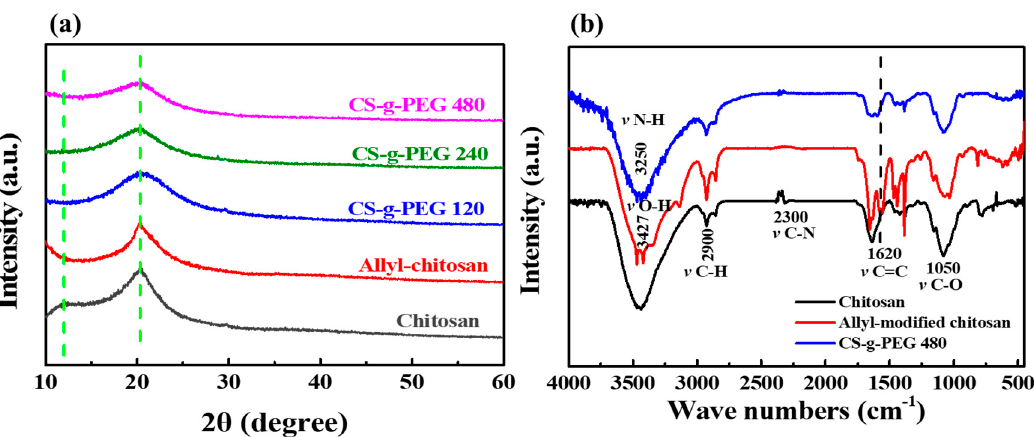
Figure 1. ( a ) X-ray diffraction (XRD) patterns of chitosan, allyl-chitosan and CS-g-PEG 120, 240 and 480, and ( b ) Fourier-transform infrared (FTIR) spectra of chitosan, allyl-chitosan and CS-g-PEG.